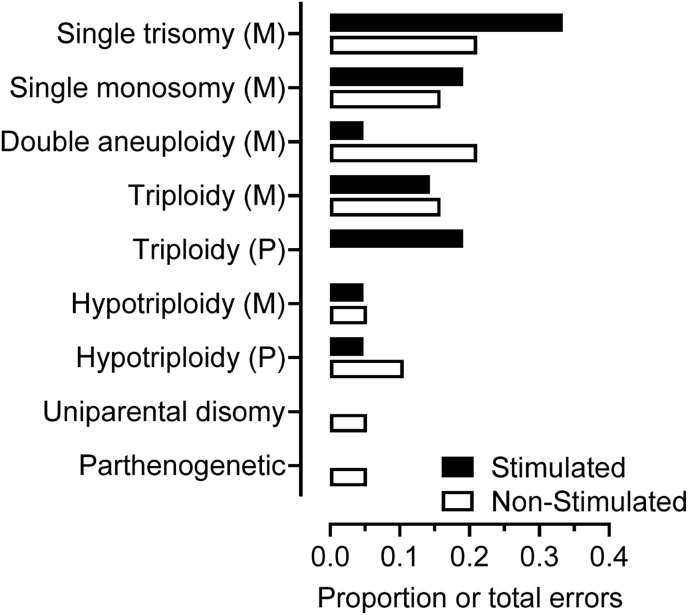
Nature of chromosomal errors expressed as a proportion of total errors in Day 8 blastocysts (n = 40). These did not differ significantly between stimulated (■) and non-stimulated (□) cycles of OPU. ‘(M)’ and ‘(P)’ refers to maternal and paternal origin respectively. ‘Double aneuploidy’ refers to combinations of maternal trisomy and/or maternal monosomy on two chromosomes.